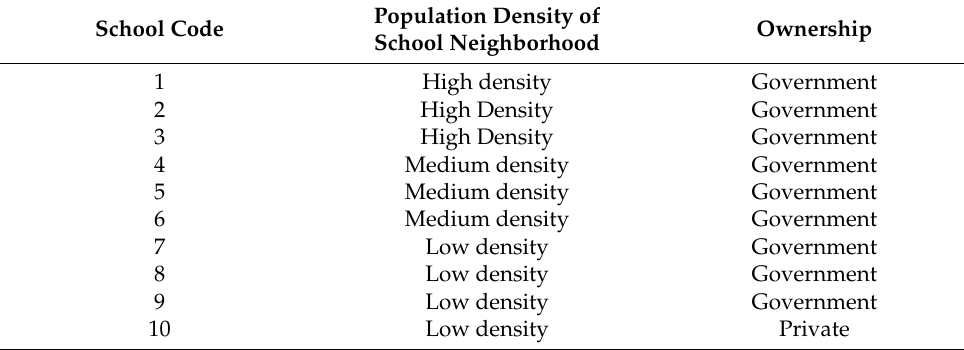
Table 1. Secondary schools in Lusaka district included in the